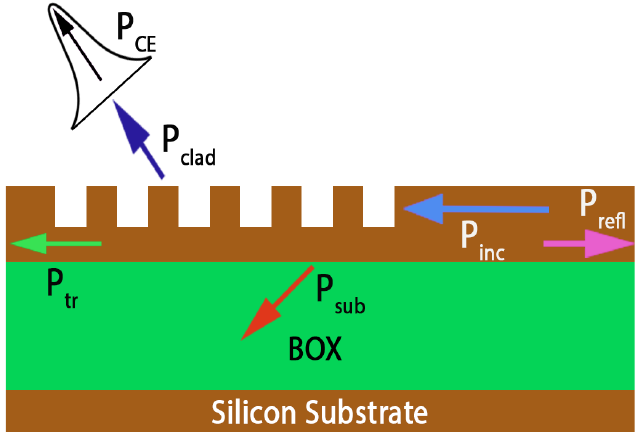
Figure 3. Illustration of different loss channels associated with a generic grating